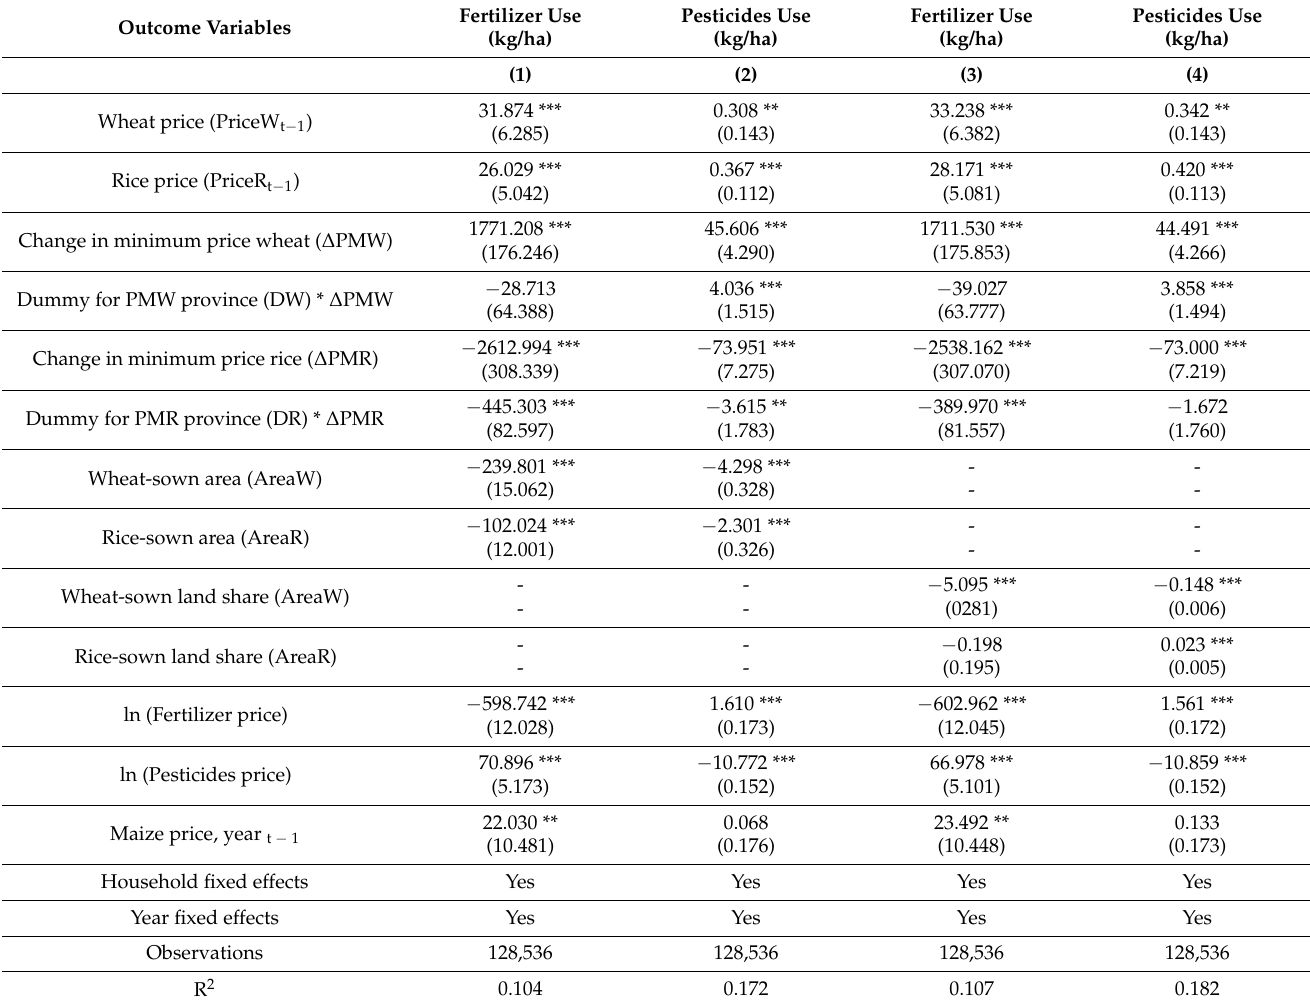
Table 5. Fixed effects regression results for agrochemical